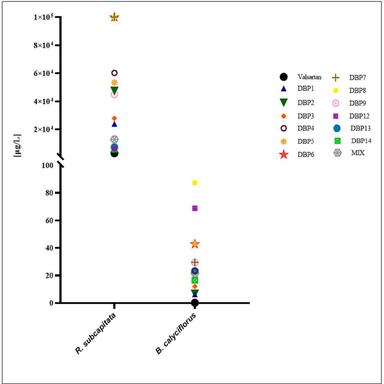
Comparison between the chronic toxicity values in R. subcapitata and B. calyciflorus. of valsartan, DBPs and MIX. Results are reported as EC50 .